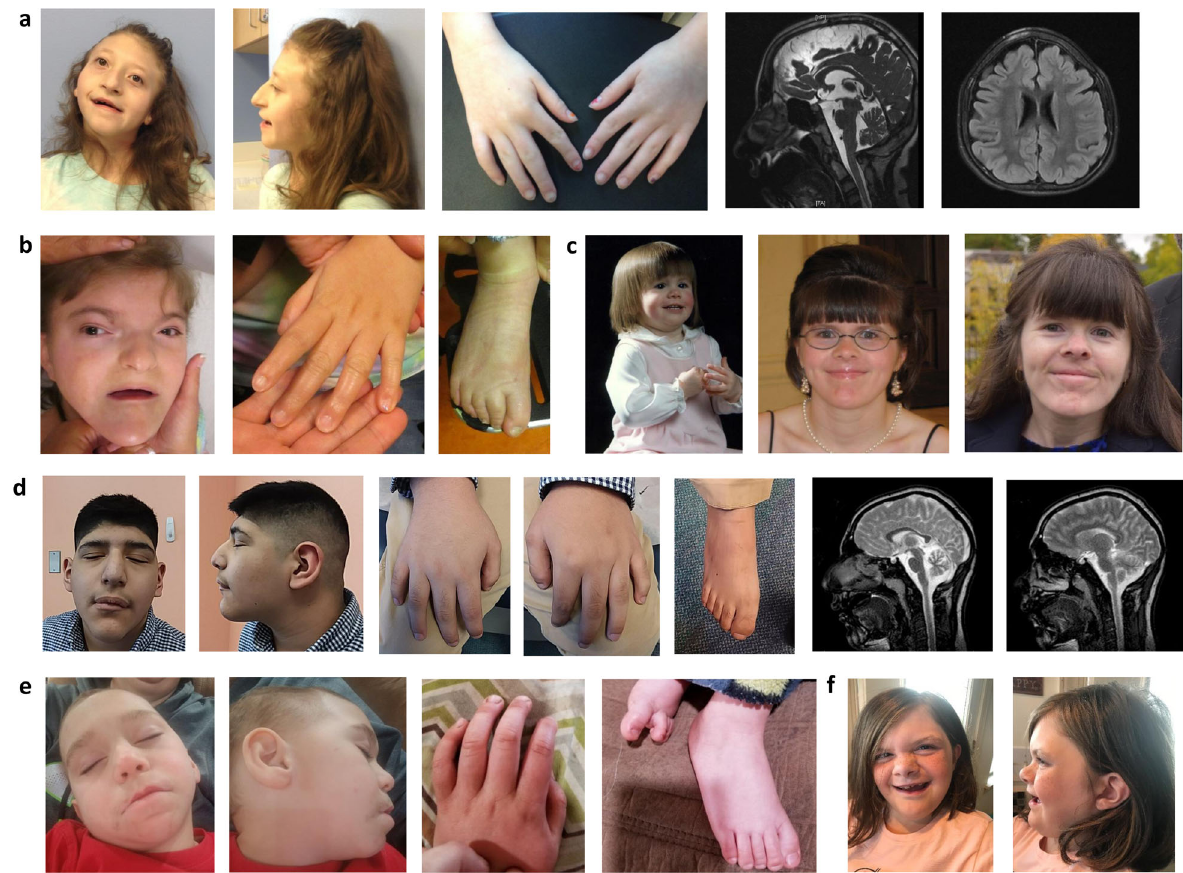
Fig. 2 Images showing dysmorphic pro fi les involving facial features, hands and/or feet, and brain MRI images for available individuals. a Individual 1, b Individual 5, c Individual 6 (left to right: 20 months, 21 years, 33 years), d Individual 8, e Individual 9, and f Individual 10. Written informed consent form has been obtained from families for the publication of facial photos, and brain MRI images when